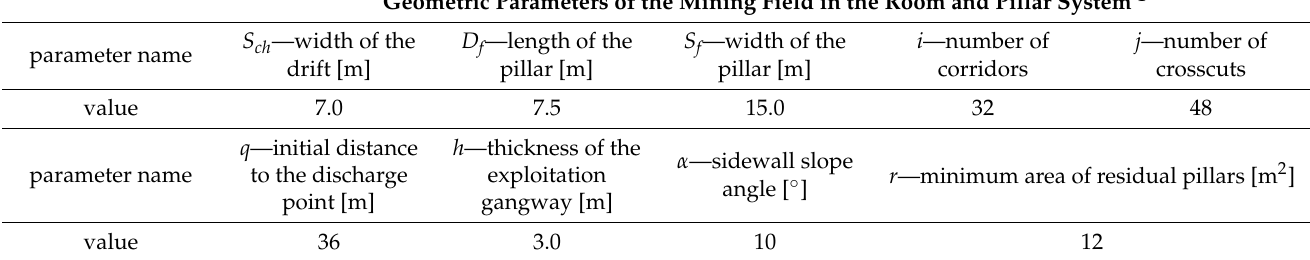
Table 2. Summary of computational geometric parameters of the mining field in the room and pillar system for the needs of simulation experiments.